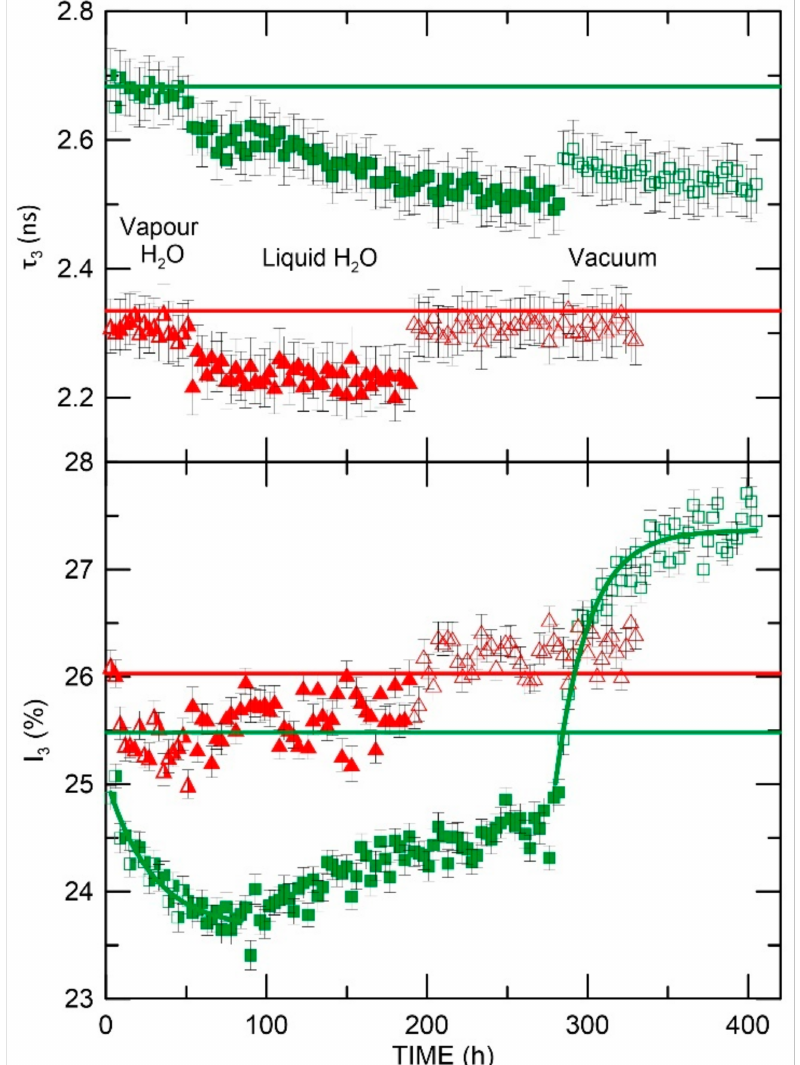
Figure 8. Dependence of o-Ps lifetime and intensity on water presence (AESO/VDM—squares, AESO/VDM/DMPA—triangles); half-full points, full points, and empty points represents the stage 1, 2, and 3 of measurement regime,